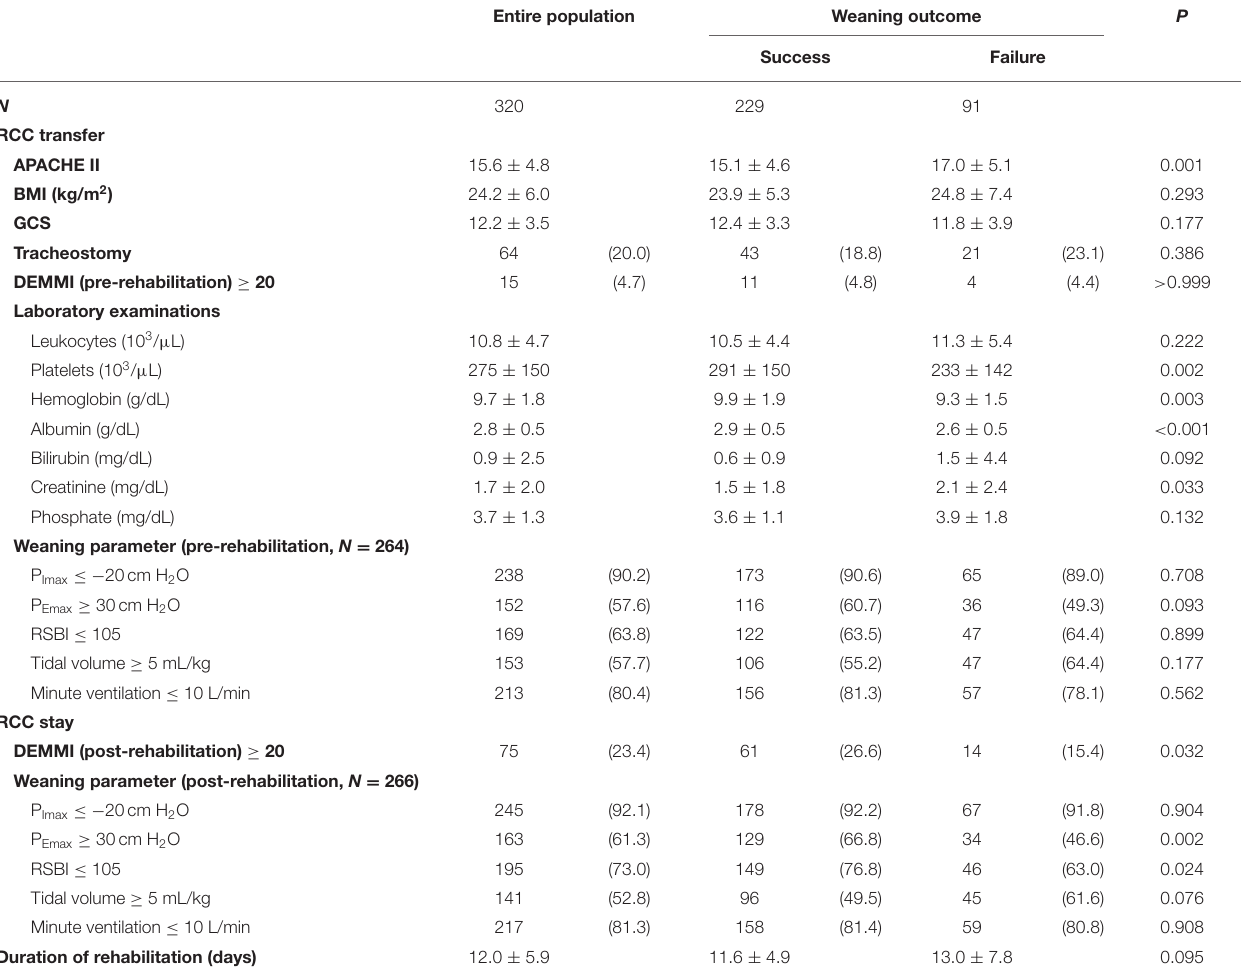
TABLE 2 | Clinical characteristics during respiratory care center hospitalization.